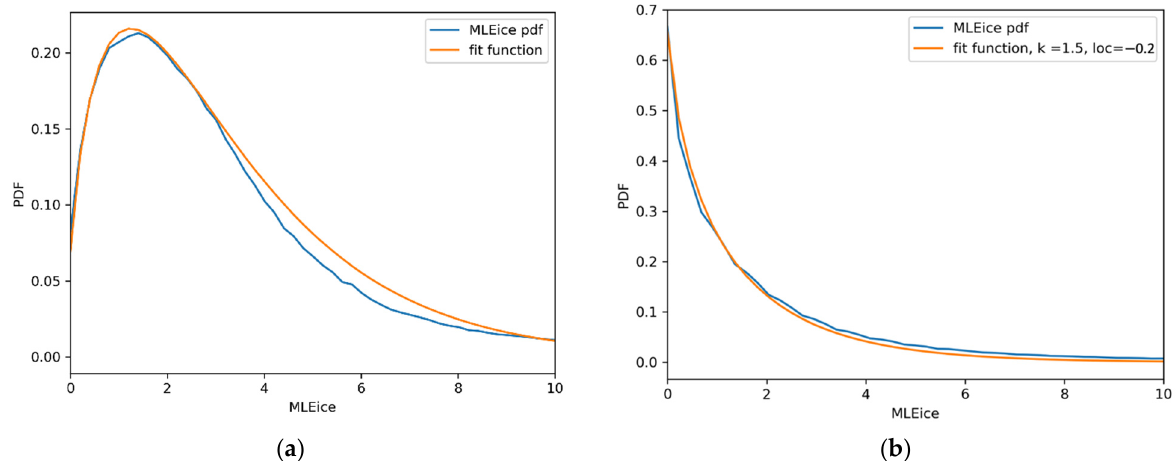
Figure 9. Probability distribution of MLE ice (normalized to unit area): blue is the observed p ( MLE ice ) , orange is the fitted probability function derived from chi-square distribution Equation (9). ( a ) p ( MLE ice ) of outer group (WVC numbers 1, 2, 41 and 42); ( b ) p ( MLE ice ) of rest group (WVC numbers from 3 to 40).